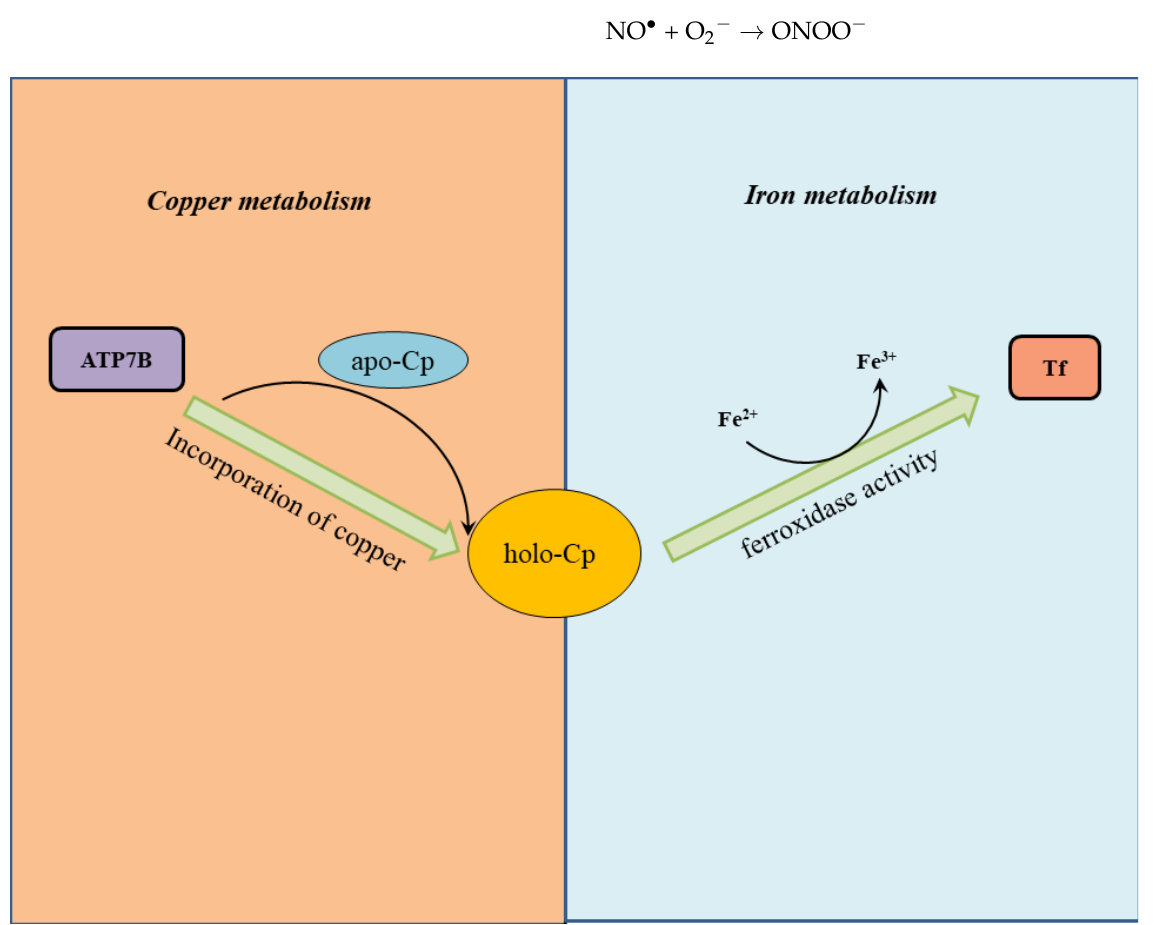
Figure 4. Ceruloplasmin is a crosstalk protein between iron and copper trafficking . Holo-ceruloplasmin (holo-Cp) is illustrated in yellow as a crosstalk protein that links iron and copper metabolism. The ATP7B copper pump in the hepatocyte uploads six copper atoms into apo-ceruloplasmin (apo-Cp). This allows the correct holo-Cp folding necessary for its ferroxidase activity: oxidation of Fe 2+ to Fe 3+ which can be then transfer to transferrin (Tf).